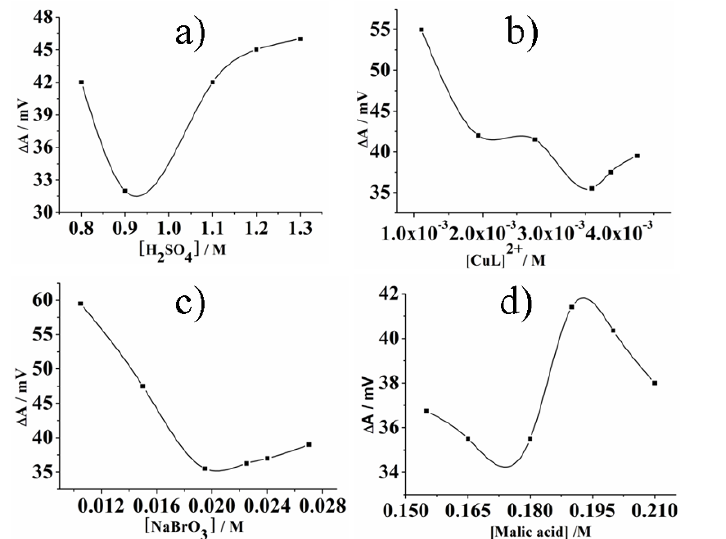
) ; (c) Sodium bromate; (d) malic acid on the pyridoxine 4 2 ] = 2×10 -5 M. (a) [NaBrO ] = 1.95×10 -2 M, 6 3 ] = 1.95×10 -2 M, [H SO ] = 1.0 M, [malic acid] = 0.18 M. (c) 3 2 4